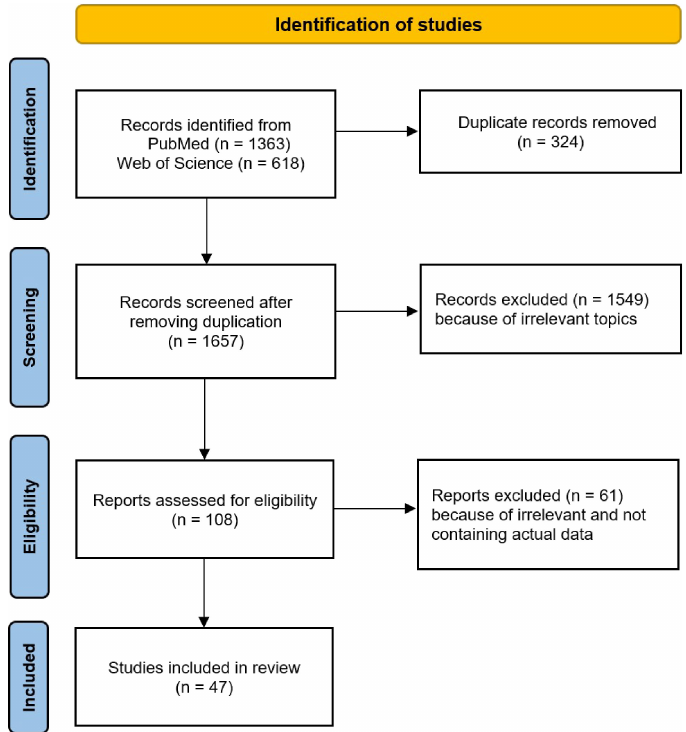
Fig. 1 Screening process of evaluated